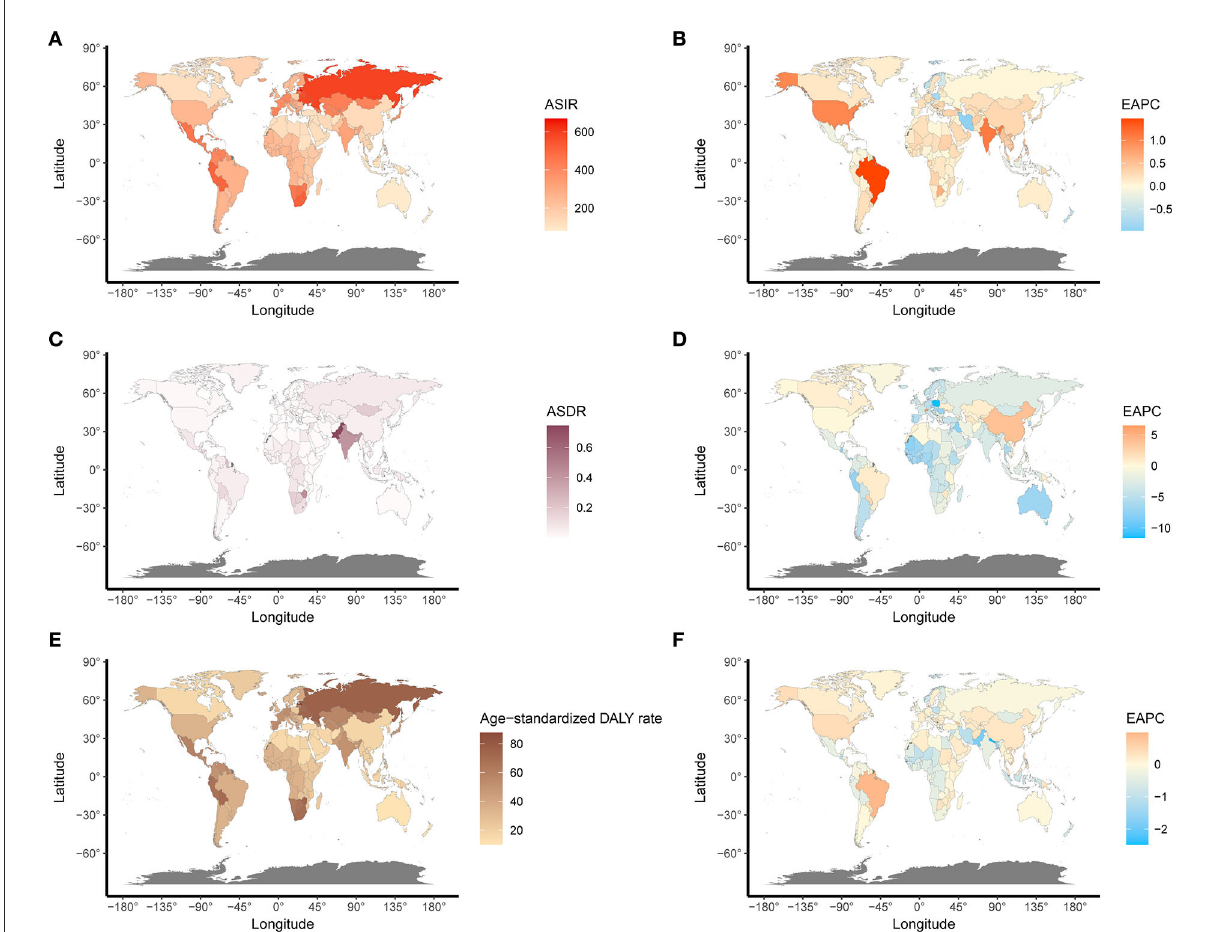
FIGURE4 The global disease burden and EAPC of UFs in 204 countries. (A) The ASIR of UFs in 2019. (B) The EAPC of ASIR. (C) The ASDR of UFs in 2019. (D) The EAPC of ASDR. (E) The age-standardized DALY rate of UFs in 2019. (F) The EAPC of age-standardized DALY rate. ASIR, age-standardized incidence rate; ASDR, age-standardized death